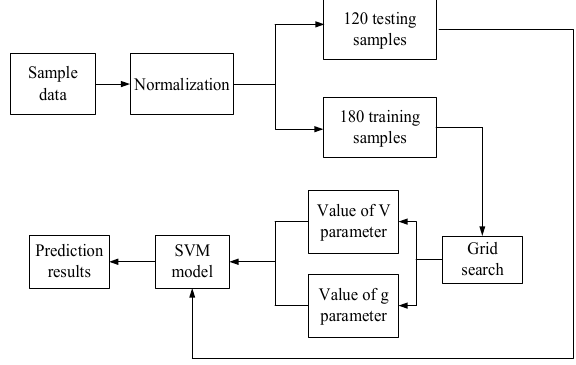
Figure 7. The process of applying the SVM model.